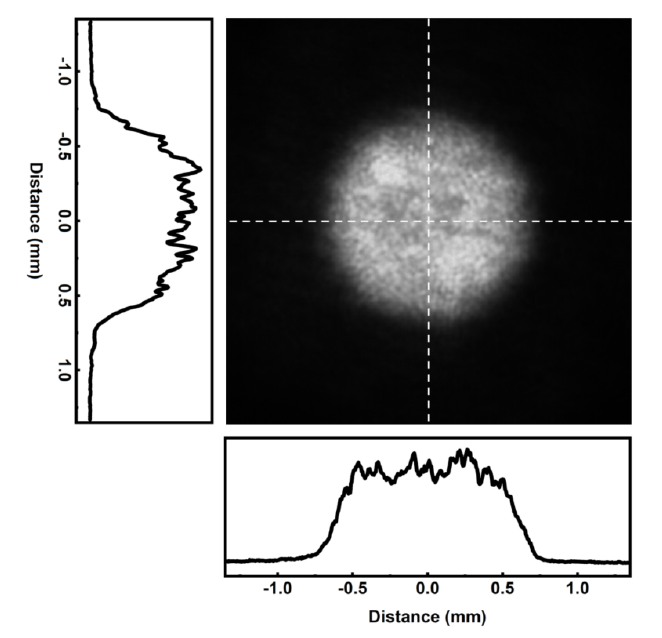
Figure 2. Laser spot profile obtained from camera measurement for a 1.2 mm laser spot with a